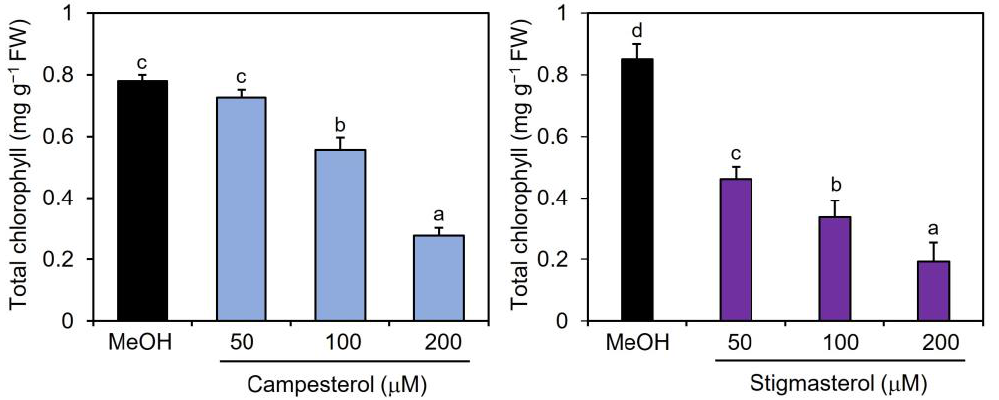
Figure 3. Effects of campesterol and stigmasterol on the accumulation of chlorophyll in Arabidopsis leaves. Arabidopsis plants were treated by soaking their roots in a solution containing various concentrations of campesterol or stigmasterol for 48 h. The leaves of the treated plants were collected and the total chlorophyll content, represented as the sum of chlorophyll a and b, was measured. As a negative control, 0.1% methanol (MeOH) was used. Values are the means ± standard deviation of three biological replicates. Different letters indicate significant differences among treatments (Tukey’s test, p < 0.05). The experiment was repeated three times with similar results.